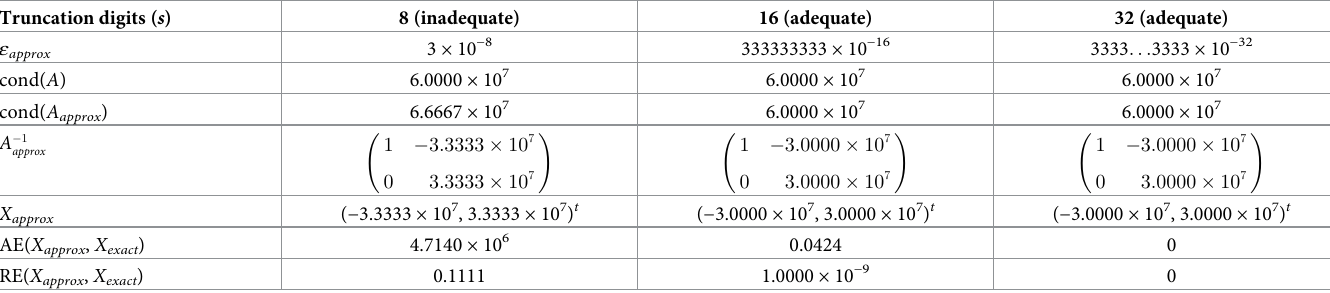
Table 4. Numeric results when precision of ε = (1/3) × 10 − 7 was increased to find an adequate number of decimal